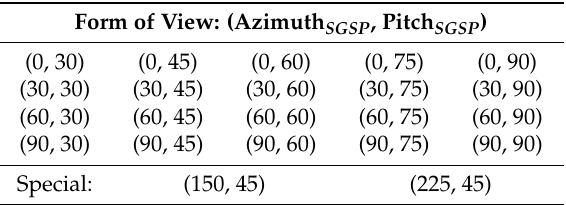
Table 2. Views of simulated images (unit: ◦ ).